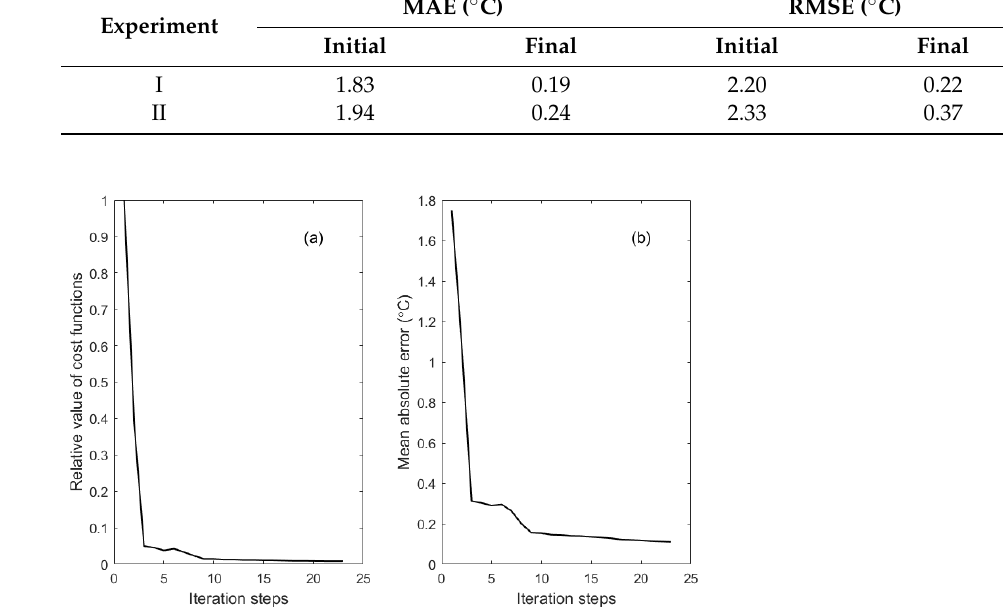
Figure 7. Cost function (a) and MAE (b) change related to the iteration steps in ideal experiment II.